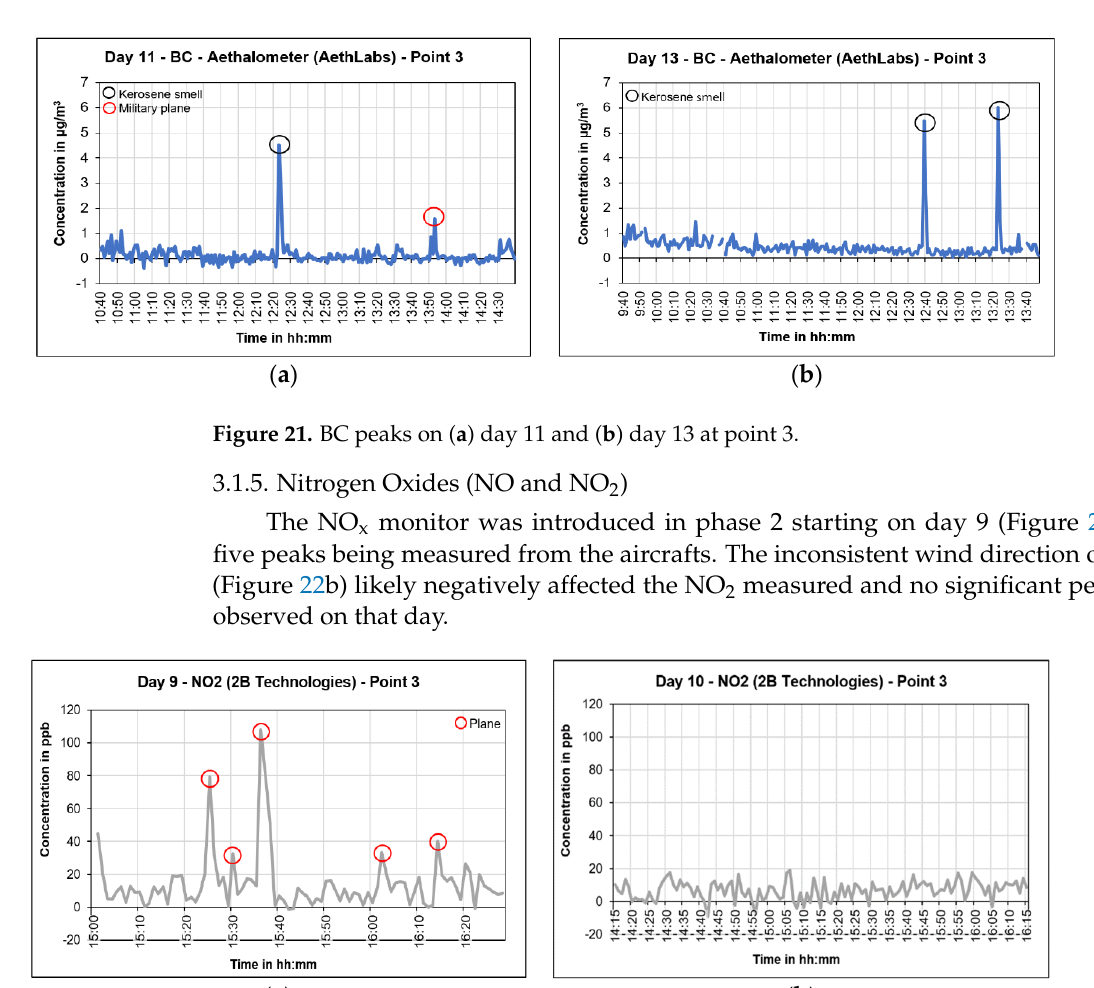
Figure 20. BC measurements during ( a ) phase 1 and ( b ) phase 2 measurements.